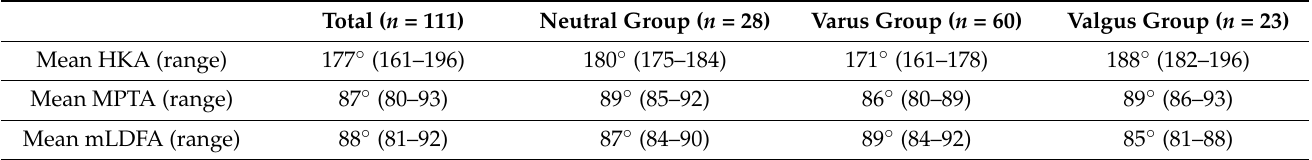
Table 2. Preoperative alignment parameters of total collective and